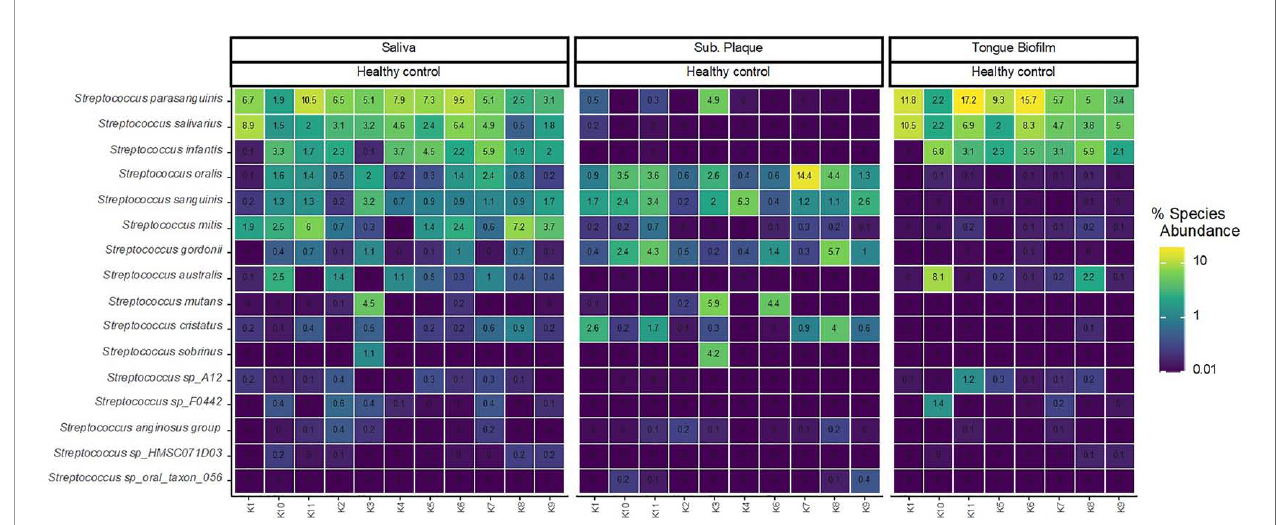
FIGURE 1 | Site-speci fi c distribution of predominant Streptococcus species. Relative abundance of the predominant Streptococcus species in 29 samples (saliva n = 11, subgingival plaque n = 10, tongue bio fi lm n = 8) in healthy conditions. Color code denotes the percentage read abundance, where light colors indicates increasing abundance and dark colors decreasing